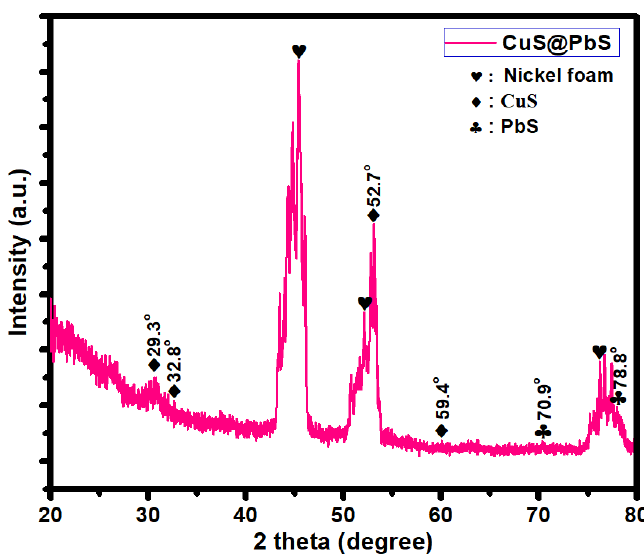
Figure 3. X-ray diffraction pattern of the prepared CuS@PbS composite.